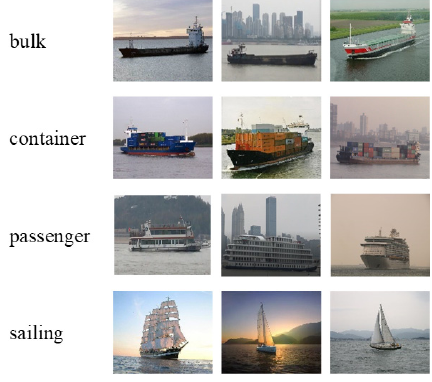
Figure 13. Sample images from each class of self-built dataset. Table 4. Number of training and test samples comprising the self-built dataset.